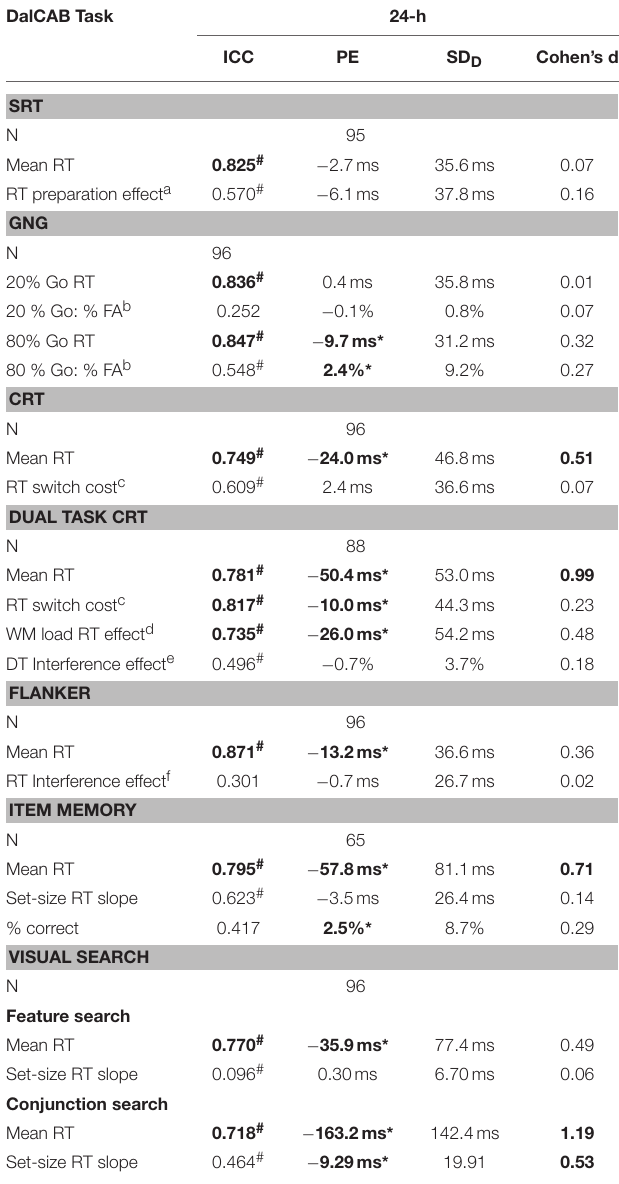
TABLE 5 | Change-based reliability statistics for participants 24-h after baseline. DalCAB